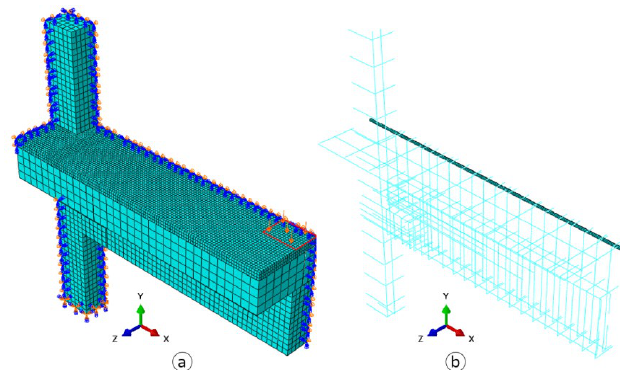
Figure 7. Boundary conditions of the calibration model.